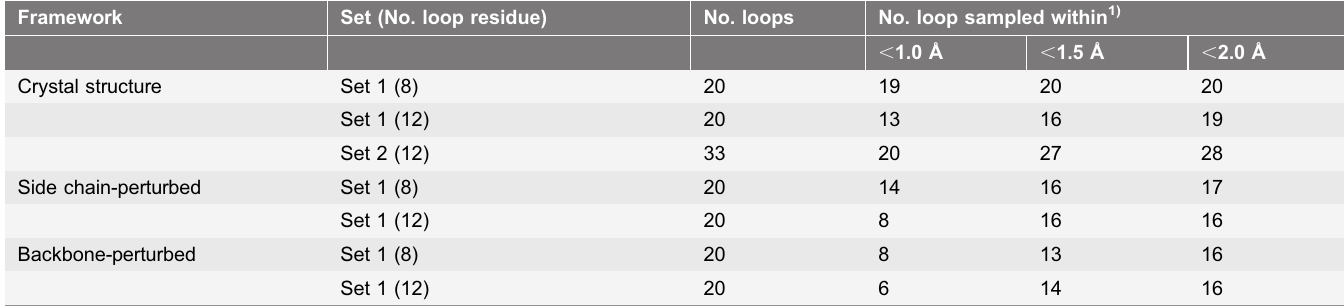
Table 3. Sampling results of GalaxyLoop-PS2 on the three test sets.